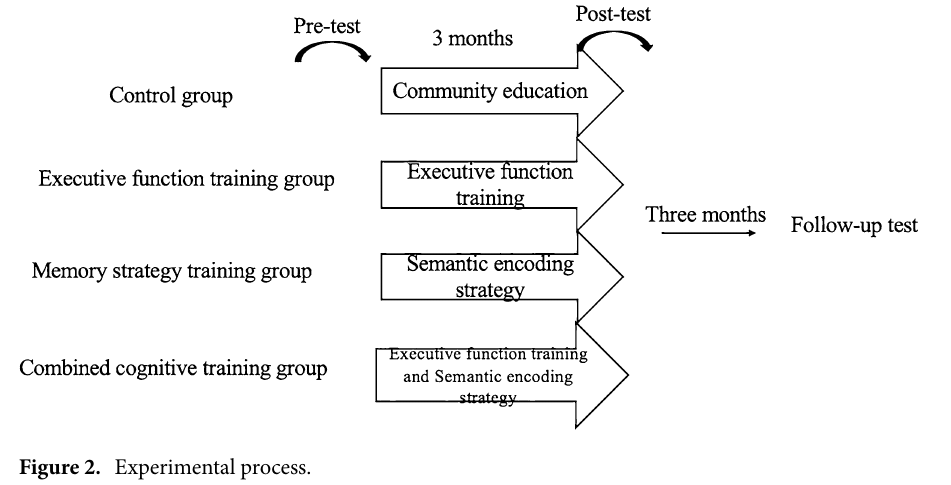
Figure 2. Experimental